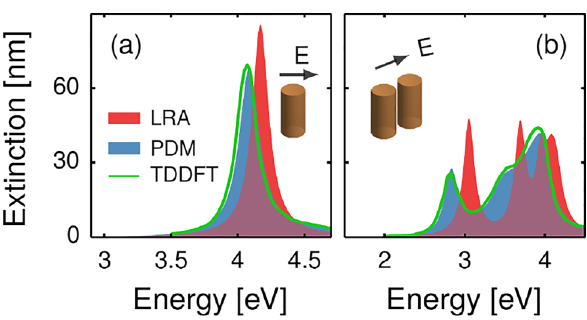
Figure 12: Extinction spectra for sodium monomers and dimers, contrasting results from local-response approximation (red-filled curve), projected-dipole model (blue-filled curve), and time-dependent density-functional theory (TDDFT) (green solid line). (a) Cylindrical wire with radius R = 4 . 9 nm, (b) cylindrical wires with radius R = 4 . 9 nm and gap g = 0 . 74 nm. The choice of these specific geometrical parameters is motivated by the corresponding availability of the TDDFT results extracted from Ref. [236]. Figure reproduced from Ref. [202] ( © 2015 American Physical